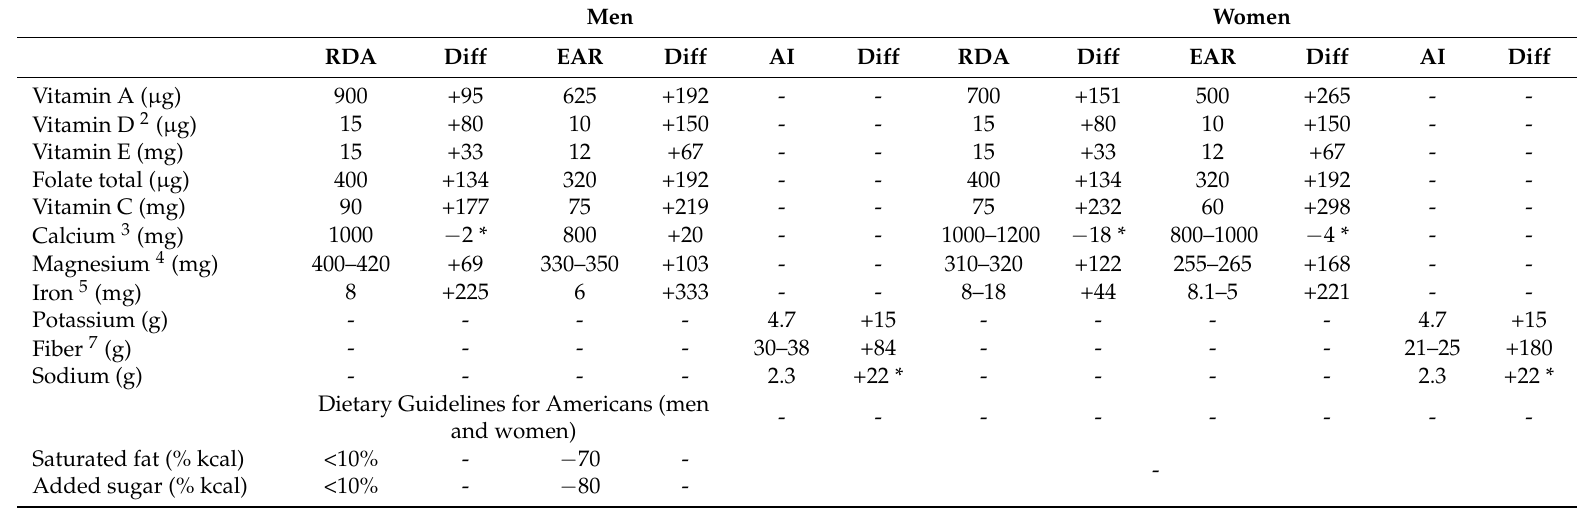
Table 3. Estimated levels of nutrients of public health concern and % differences (greater or lesser) of WFPB diets compared to recommendations. 1,